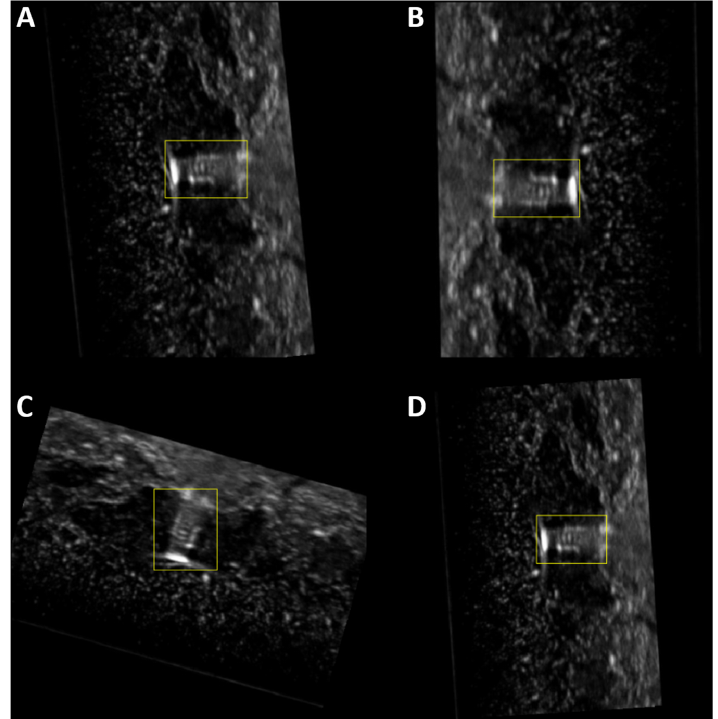
Figure 2. Augmented Shrapnel Images and Corresponding Bounding Boxes. ( A – D ) Single repre- sentative images having undergone random image augmentation four times. Image augmentation included X and Y flips or reflection, rotation, and zoom or scaling. All image augmentation per- formed to a single image was applied to the corresponding bounding box(es) as well as shown.